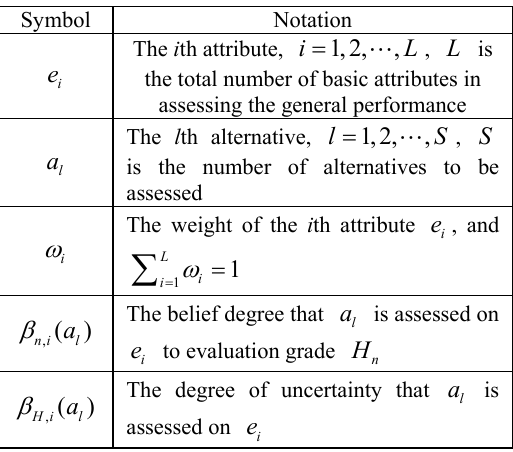
Table 1. Notation of the main